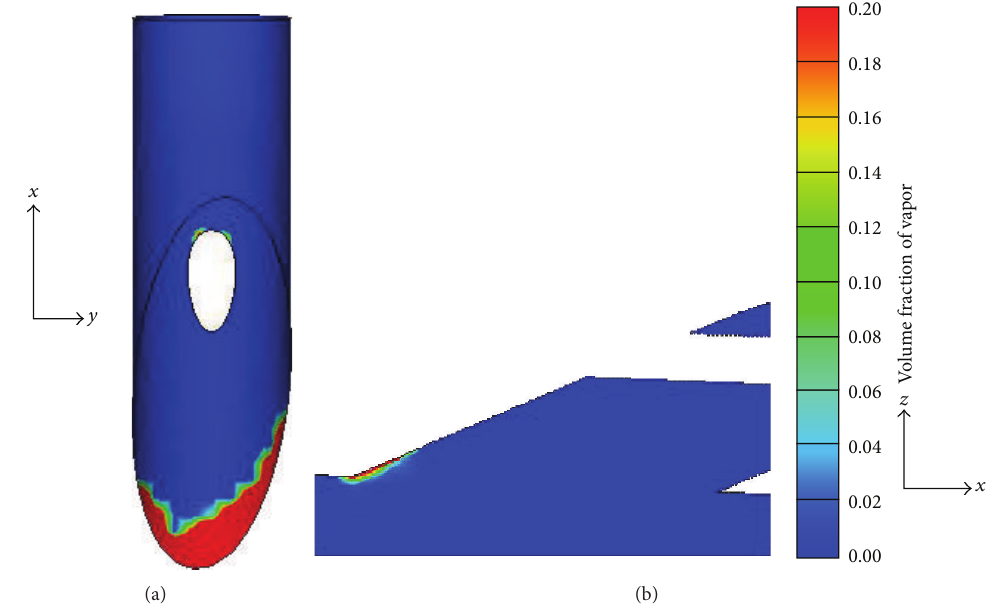
Figure 12: (a) Volume fraction of vapor contours showing cavitation at the lip region of the pump casing: view from the top, the oval white region in the middle corresponds to the shaft. (b) Volume fraction of vapor contours along the center-plane of the waterjet, showing cavitation at the lip region of the inlet.